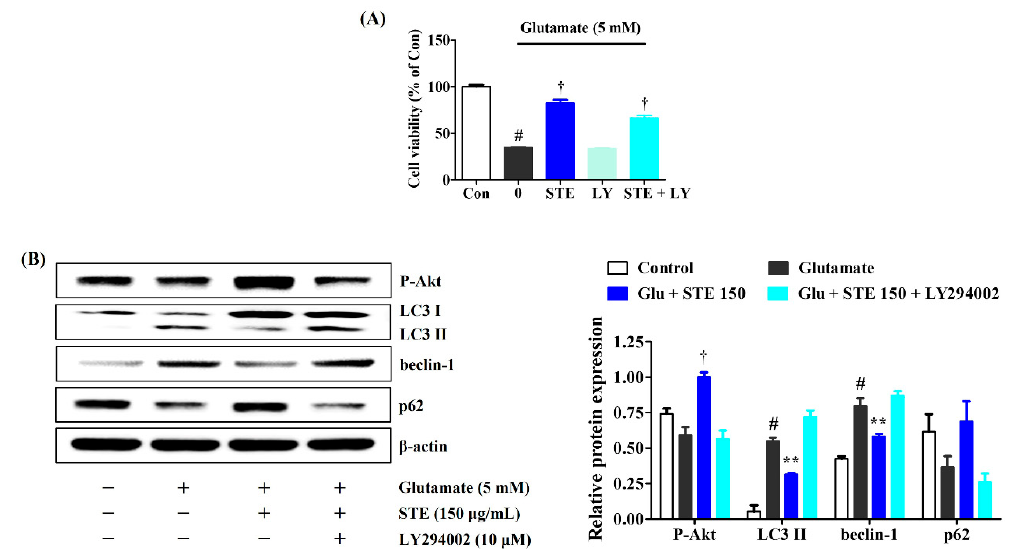
Figure 7. Suppressive effects of LY294002 on the neuroprotective action of Selaginella tamariscina ethanol extract (STE). HT22 cells were incubated with or without STE combined with LY294002 before glutamate treatment. ( A ) Cell viability and ( B ) the expression of phospho-protein kinase B, light chain 3 II, Beclin-1, and p62 were assessed using a cell-counting kit and Western blot, respectively. Control cells were incubated with the vehicle alone. Blot images represent three independent experiments. Data are presented as mean ± standard error of the mean. Con, control; LY, LY294002; Akt, protein kinase B; LC, light chain; Glu, glutamate. Statistical significance was defined as # p < 0.05 (vs. control), ** p < 0.01, and † p < 0.001 (vs. glutamate).